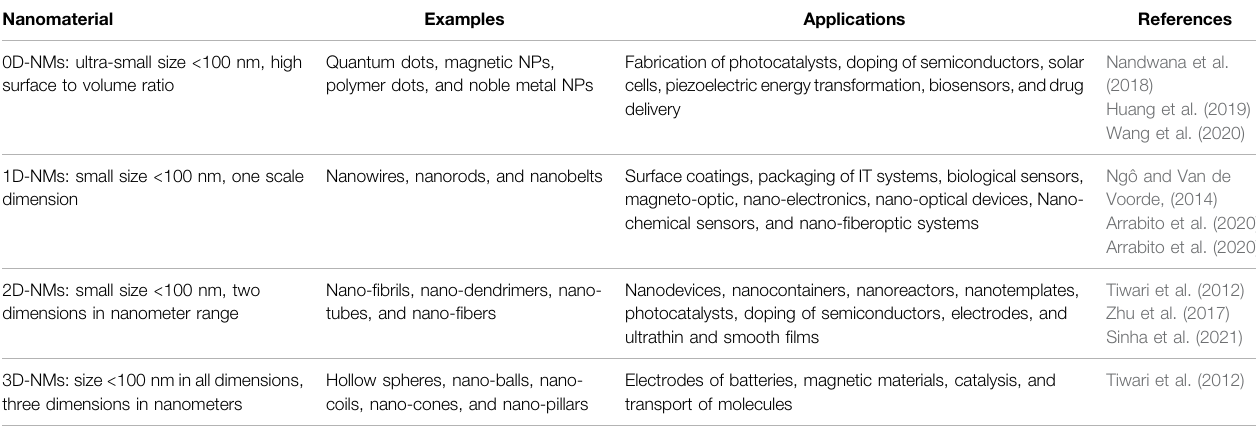
TABLE 1 | Size, examples, and applications of 0D, 1D, 2D, and 3D